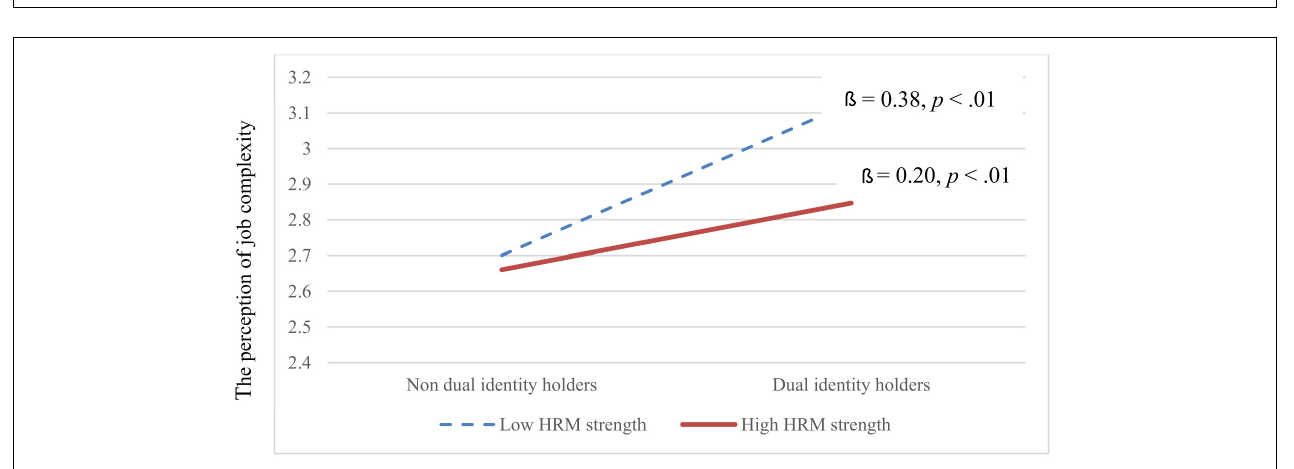
FIGURE 3 | Cross-level moderating effect of HRM strength on the relationship between dual-identity holders and the perception of internal CSR efforts.